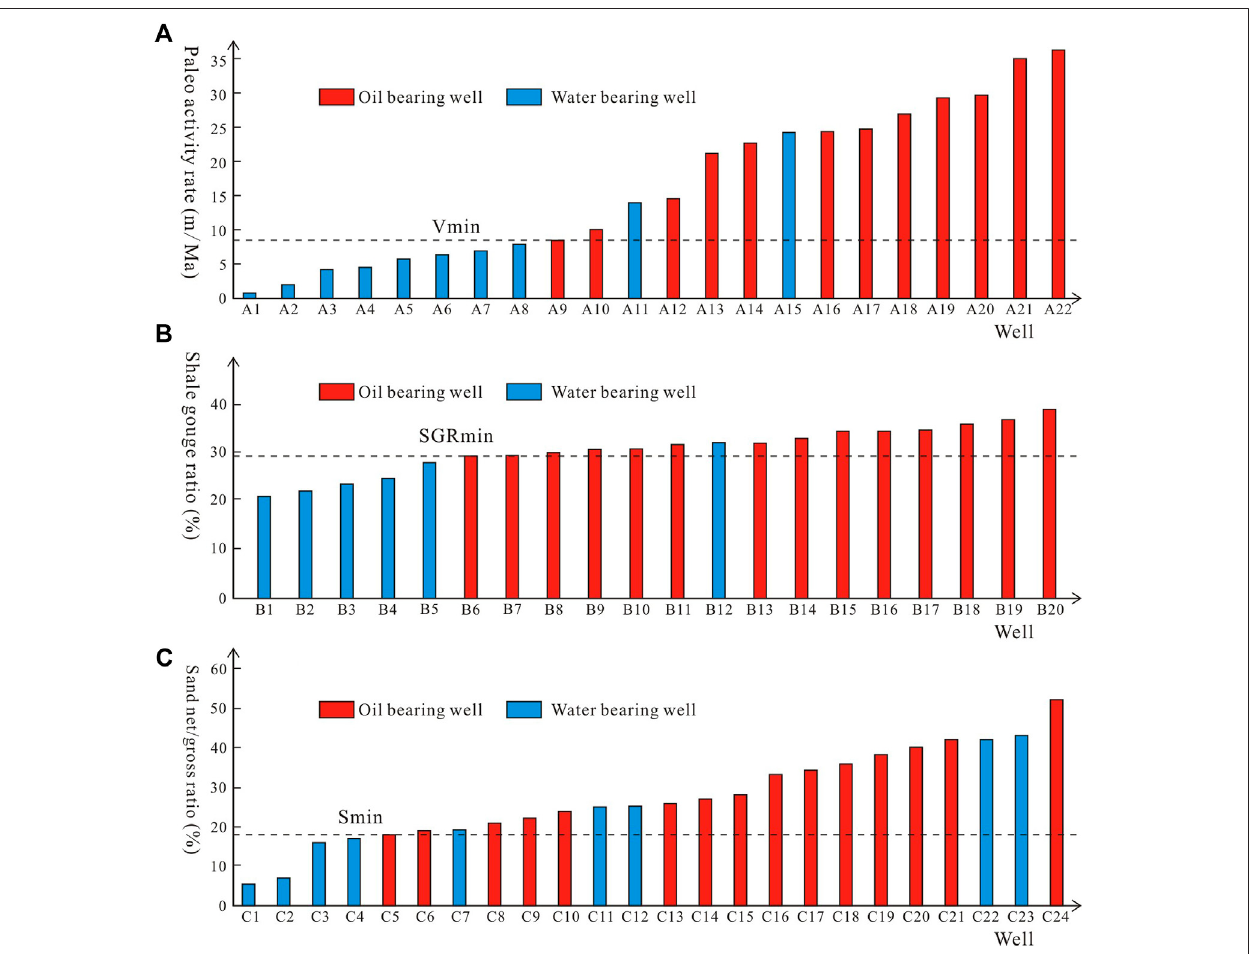
FIGURE 2 | Schematic diagram of determining the thresholds of hydrocarbon transportation and accumulation (modi fi ed from Fu and Yu, 2021; Zhang and Fu, 2022). (A) Determination of threshold required for oil-source faults to transport hydrocarbons. (B) Determination of threshold required for faults to laterally seal hydrocarbons. (C) Determination of threshold required for sand bodies tostore hydrocarbons. V min = threshold of paleo activity rate; SGR min =threshold ofshale gouge ratio; S min = threshold of sand net/gross